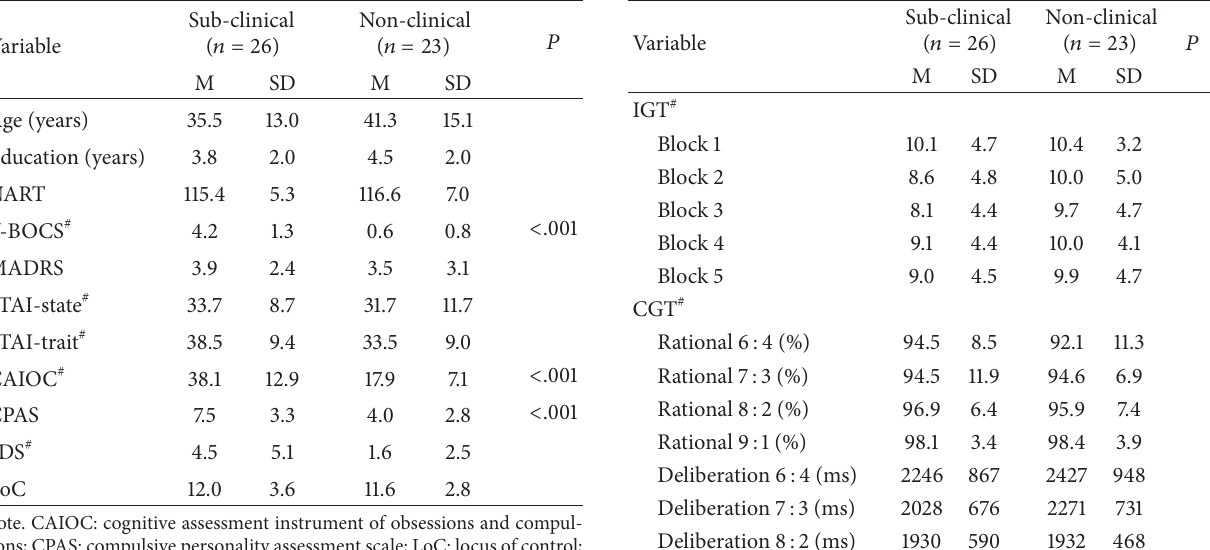
Table 1: Demographic, clinical, and psychological background characteristics in the sub-clinical and non-clinical groups.